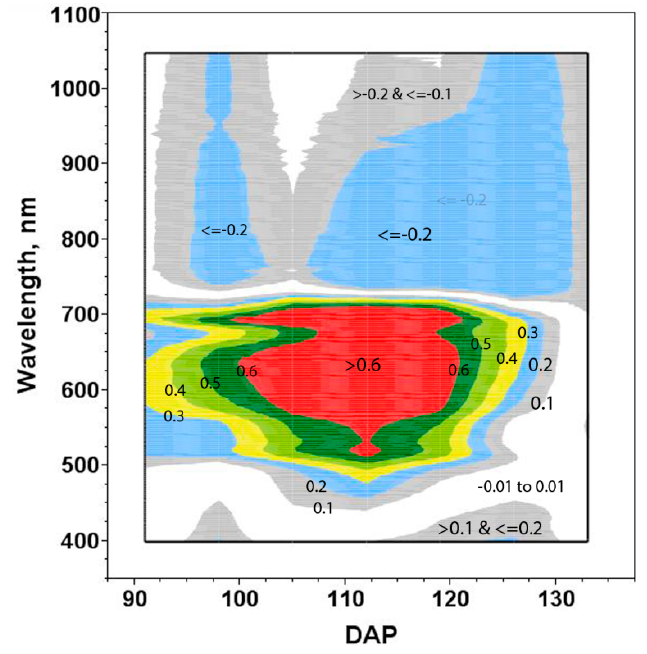
Figure 3. A contour plot of linear correlation between leaf reflectance at different wavelengths and disease rating as a function of days after planting (DAP). Table 4. The ten best wavebands for disease discrimination, selected through three different methods namely linear discriminant analysis (DA), logistic discriminant analysis, and linear correlation analysis on the pooled data.